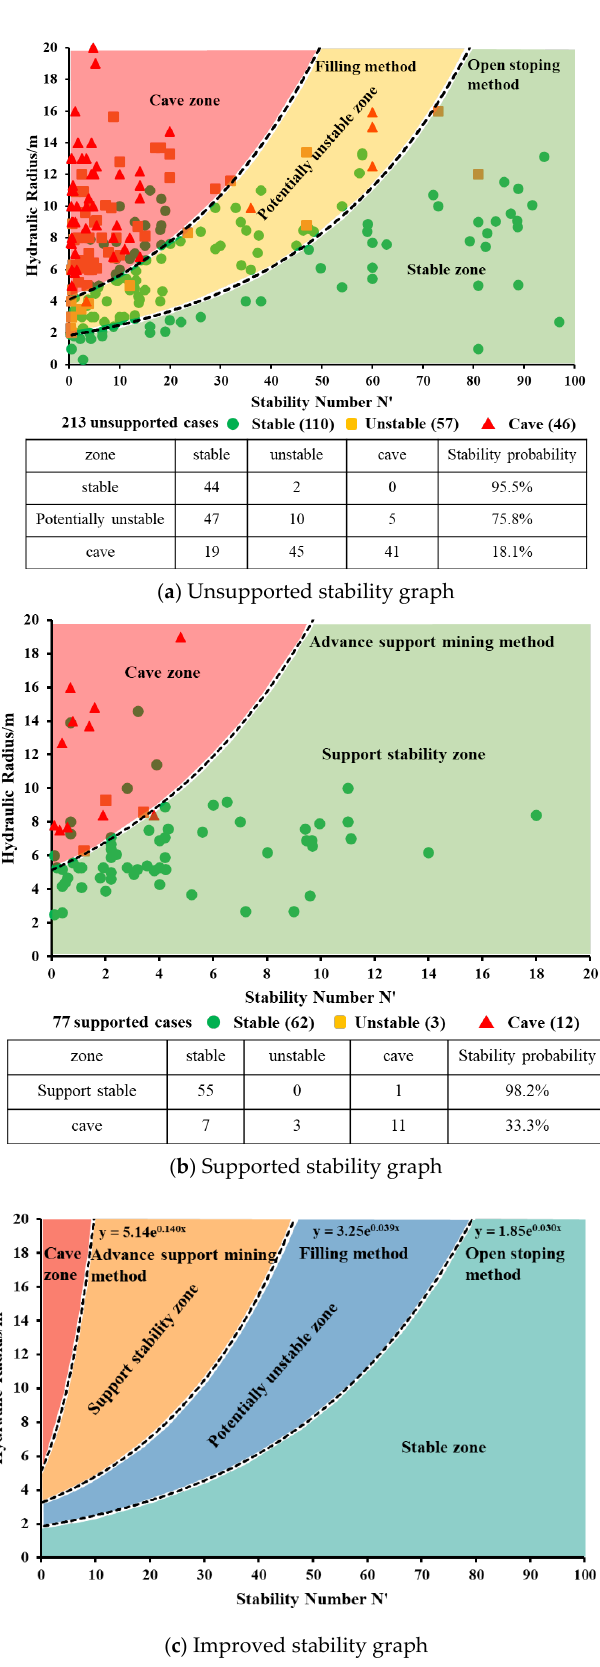
Figure 6. Improved stability graph. ( a ) Unsupported stability graph; ( b ) Supported stability graph; ( c ) Improved stability graph.